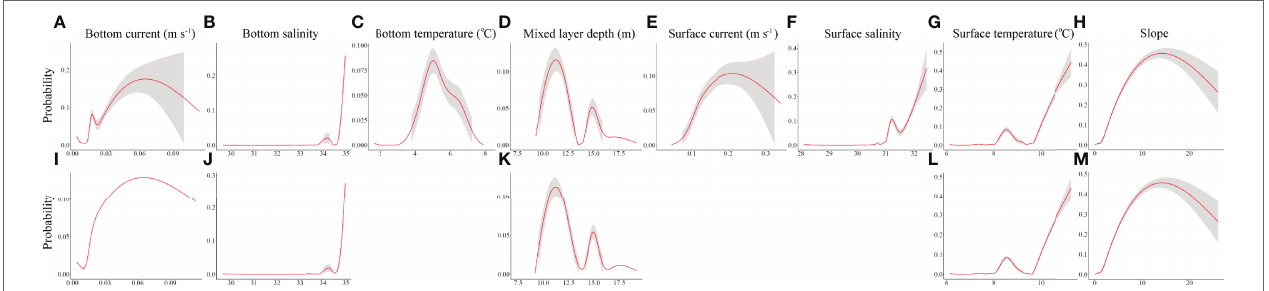
FIGURE 6 | Functional response curves for RF models (A–H) and GAMs (I–M) constructed using 8 environmental predictors, under present-day conditions. (Three predictors not included in the GAMs are left blank). Shaded regions represent approximate 95% confidence intervals. All curves and confidence intervals were bounded at zero probability. (MLD, mixed layer depth. Units are as in Supplementary Table 2 ).